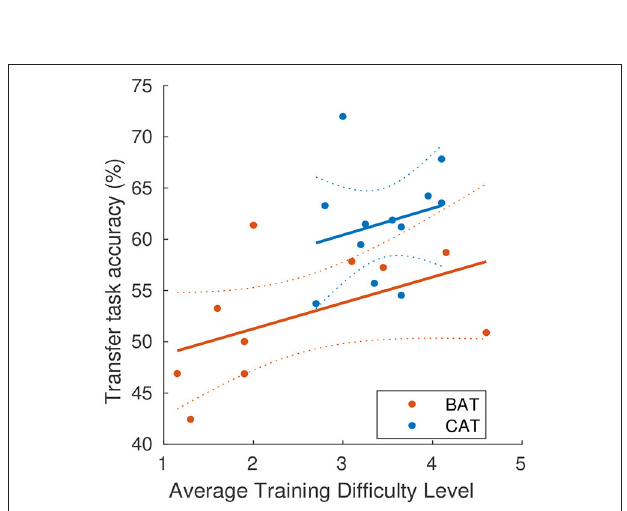
FIGURE 4 | Differences in training difficulty do not account for the transfer performance advantage of CAT. Here, we excluded SIFD condition as it was fixed at easiest level. Dashed lines show 95% confidence intervals of the